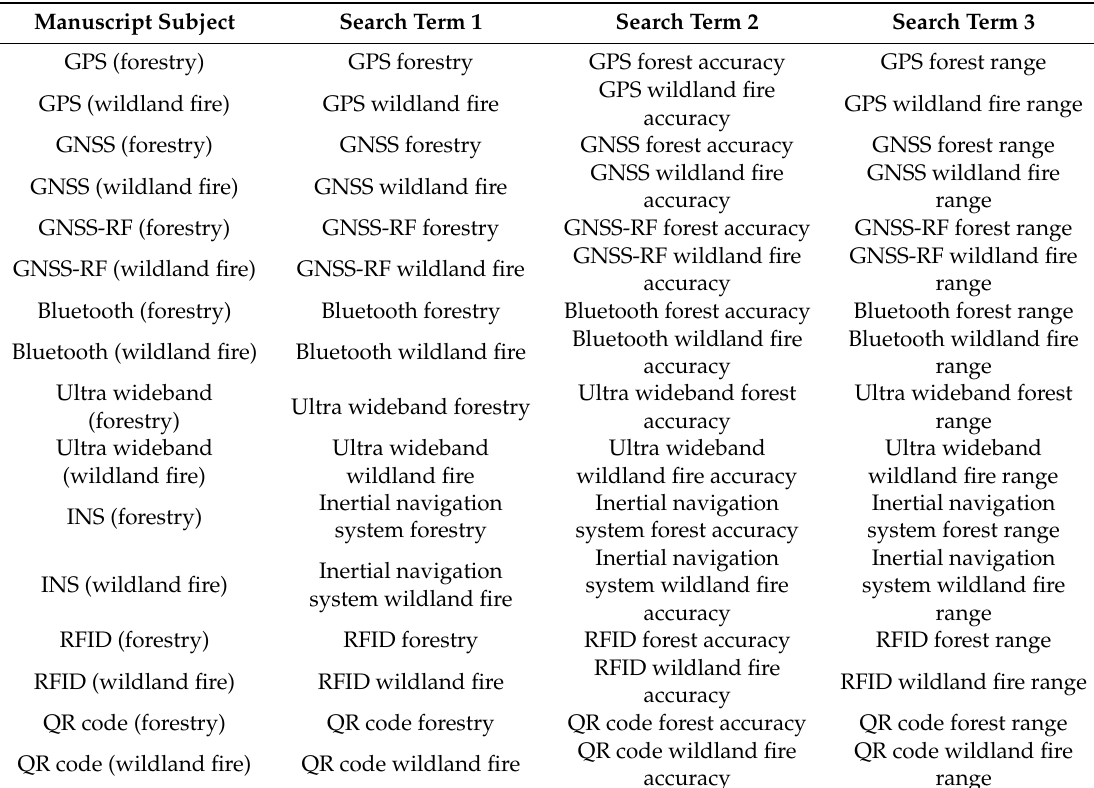
Table A1. Search terms used in Google Scholar for manuscript Section